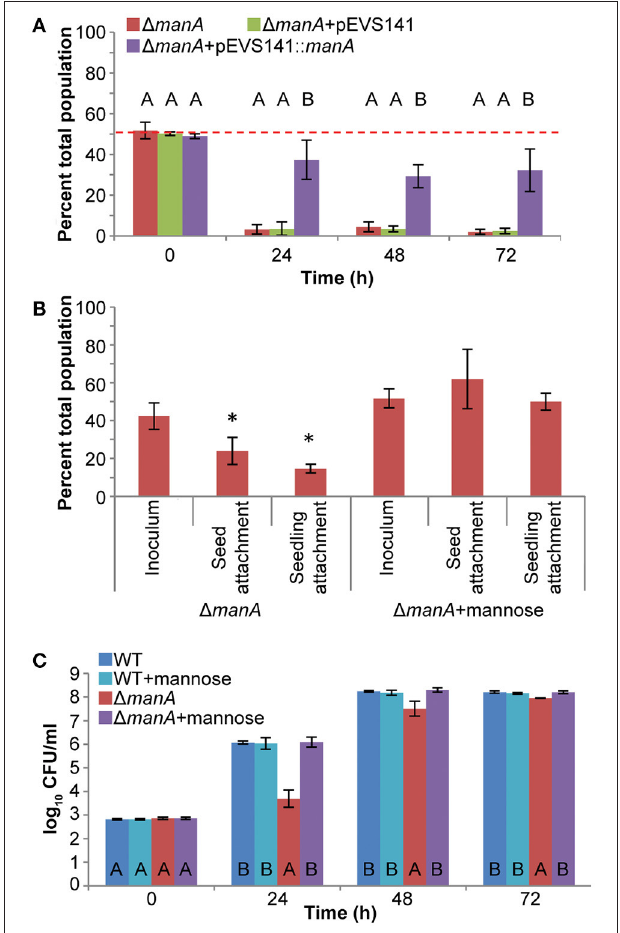
FIGURE 4 | Mannose is required for S. enterica plant colonization. (A) SL1344 1 manA ::Cm had a severe competitive colonization defect on alfalfa seedlings. Bars show the mean percent of the total population comprised of 1 manA following a 1:1 co-inoculation with the isogenic WT. *, statistically different from 50% (One-sample t -test, n = 3, p < 0.05). Letters above bars, statistically different groups within each time point (Tukey’s HSD, n = 9, p < 0.05). (B) Mannose contributed to S. enterica attachment to alfalfa seeds and 3 day-old seedlings. The attachment defect of 1 manA ::Cm was fully complemented by addition of 0.2mM mannose. Bars show the mean percent of the total population comprised of 1 manA following a co-inoculation with the isogenic WT. *, statistically different from the inoculum (Paired t -test, n = 6, p < 0.05). (C) Mannose contributes to S. enterica growth in alfalfa seedling exudates in vivo . The growth defect of 1 manA ::Cm was fully complemented by addition of 0.2mM mannose. Letters at the bottom of the bars, statistically different groups within each time point (Tukey’s HSD, n = 36, p < 0.05). For all experiments, data shown are the means of 3 independent experiments with 3 replicates each. Error bars indicate the standard deviation.